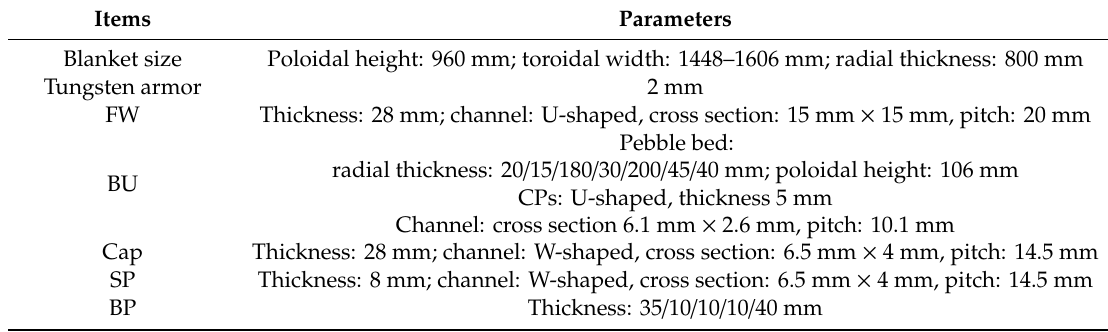
Figure 3. Schematic view of the typical Helium-Cooled Solid Breeder (HCSB) blanket module. Table 1. Dimensions of the main parts of the typical HCSB outboard blanket module.